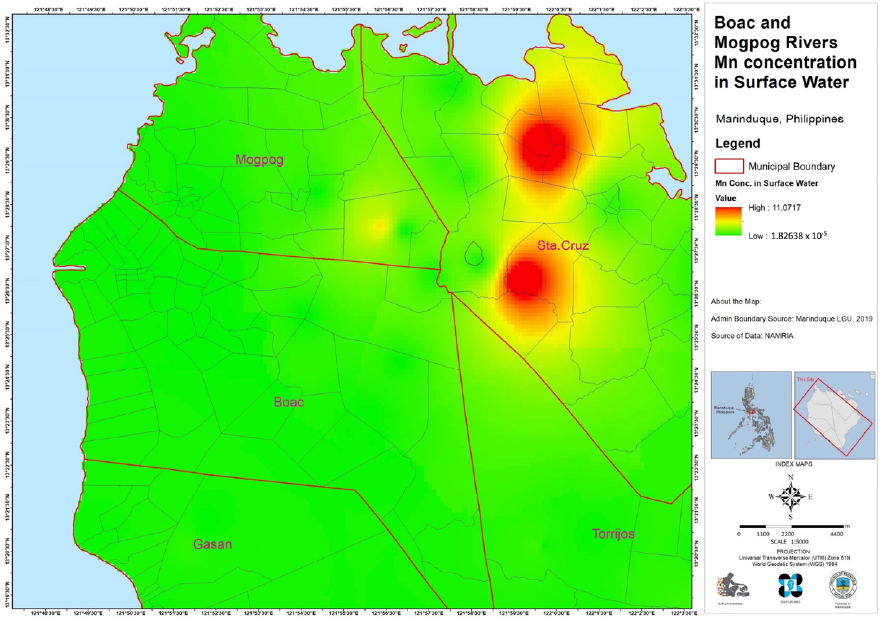
Figure A6. Spatial map for Mn concentration in Surface Water.